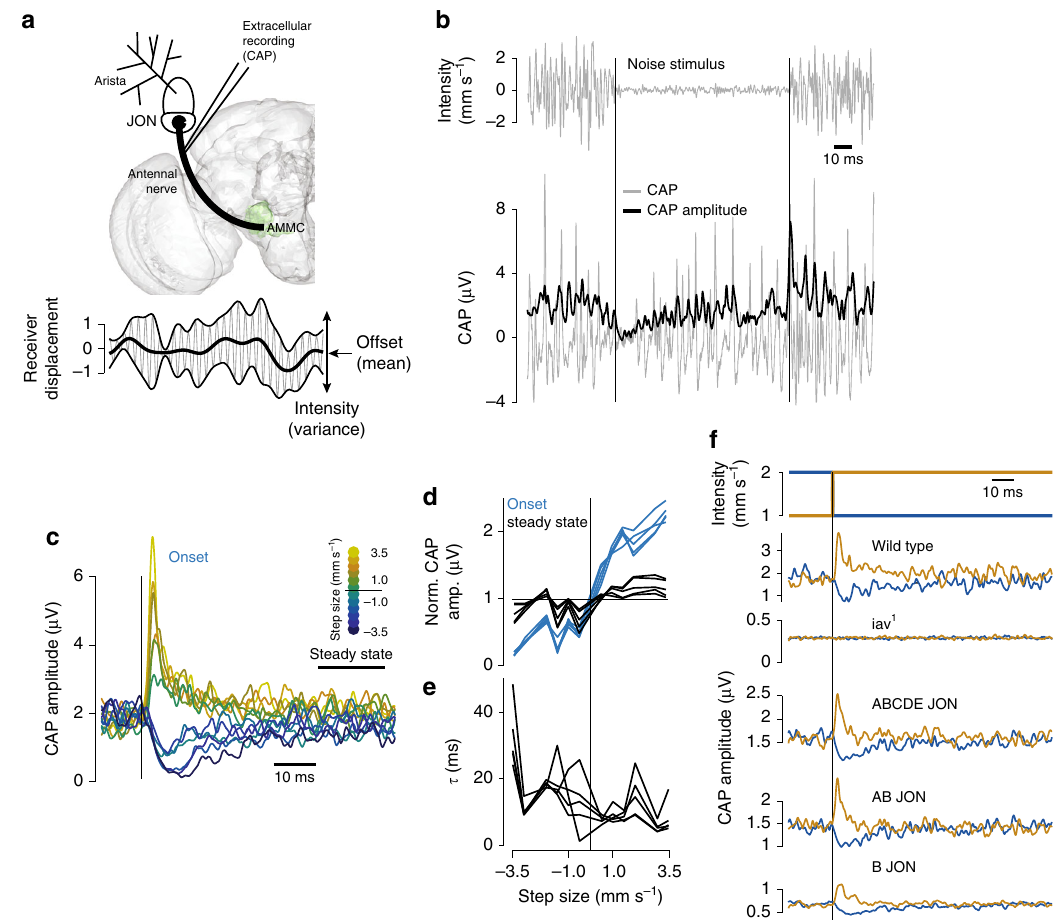
Fig. 1 Sound intensity (variance) adaptation in JO neurons. a (top) Frontal view of the fl y brain (left half) with schematic of the antenna. Sound-induced antennal vibrations activate antennal mechanosensitive neurons within the Johnston ’ s organ (JO) — a subpopulation of JO neurons (JONs) serves as the auditory receptor neurons. JON spikes travel down the antennal nerve to the antennal mechanosensory and motor center (AMMC, green) for central processing of acoustic stimuli. The compound spiking activity (CAP or compound action potential) of the JONs can be recorded extracellularly from the antennal nerve. (bottom) The mean (thick black line) of antennal displacements corresponds to a slowly changing offset; the variance (thin black lines) to the magnitude of sound-induced vibrations (sound intensity). b CAP recording (bottom, gray, averaged over 20 trials, see Supplementary Fig. 1b for single trial CAPs) in response to a noise stimulus (top) switching intensity every 100 ms. The CAP amplitude (bottom, black) was calculated using the Hilbert transform and exhibits transients after each intensity switch (vertical black lines). c CAP amplitude traces for all step sizes (color coded) aligned to step onset (vertical black line), for one fl y. While the onset response strongly depends on step sign and magnitude, the steady-state response is relatively independent of step size. d Peak of onset and steady-state responses (blue and black, respectively) as a function of step size ( N = 5 fl ies). Normalized for each fl y such that the average steady-state response across step sizes is 1.0. e Timescale of adaptation τ obtained by fi tting an exponential to the transients in the CAP amplitude ( N = 5 fl ies). f Responses of wild-type, iav 1 mutants and Iav -rescues in different JON subsets to steps in noise intensity (from 1 to 2 mm s − 1 (brown) and from 2 to 1 mm s − 1 (blue), example data from one fl y each, see also Supplementary Fig. 1d, e). CAP signals are abolished in iav 1 fl